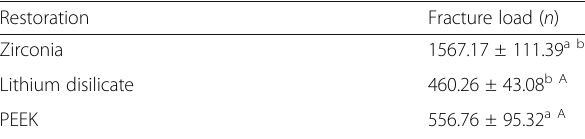
Table 2 Mean and standard deviations of fracture resistance values ( n ) of experimental